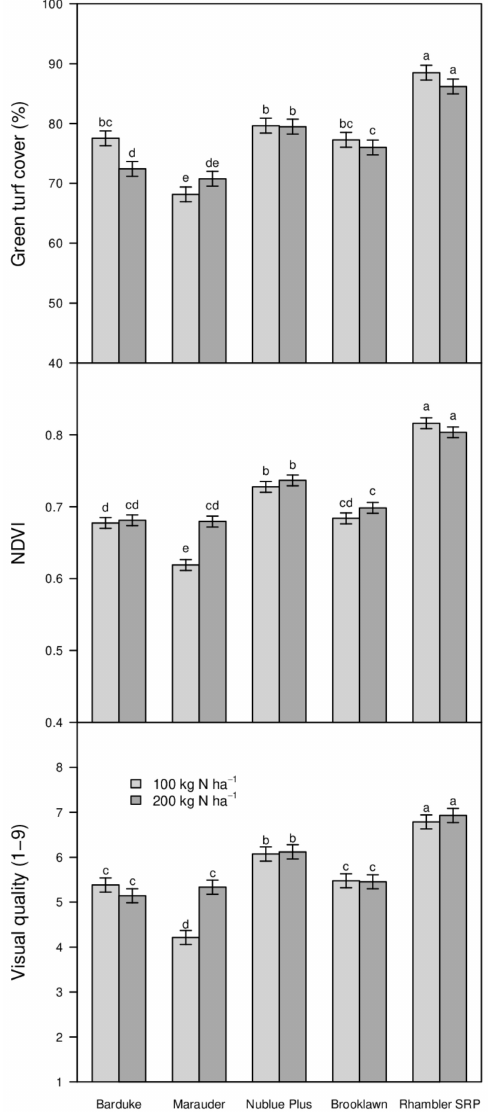
Figure 3. Green turf cover, NDVI and visual quality of four Kentucky bluegrass cultivars (‘Barduke’, ‘Marauder’, ‘NuBlue Plus’, ‘Brooklawn’) and a tall fescue cultivar (‘Rhambler SRP’) at two N fer- tilisation rates (100 and 200 kg ha − 1 yr − 1 ) in 2020 (June–September 2020). Mean values with the same letters are not significantly different based on the LSD test at a probability of 0.05. Bars are standard